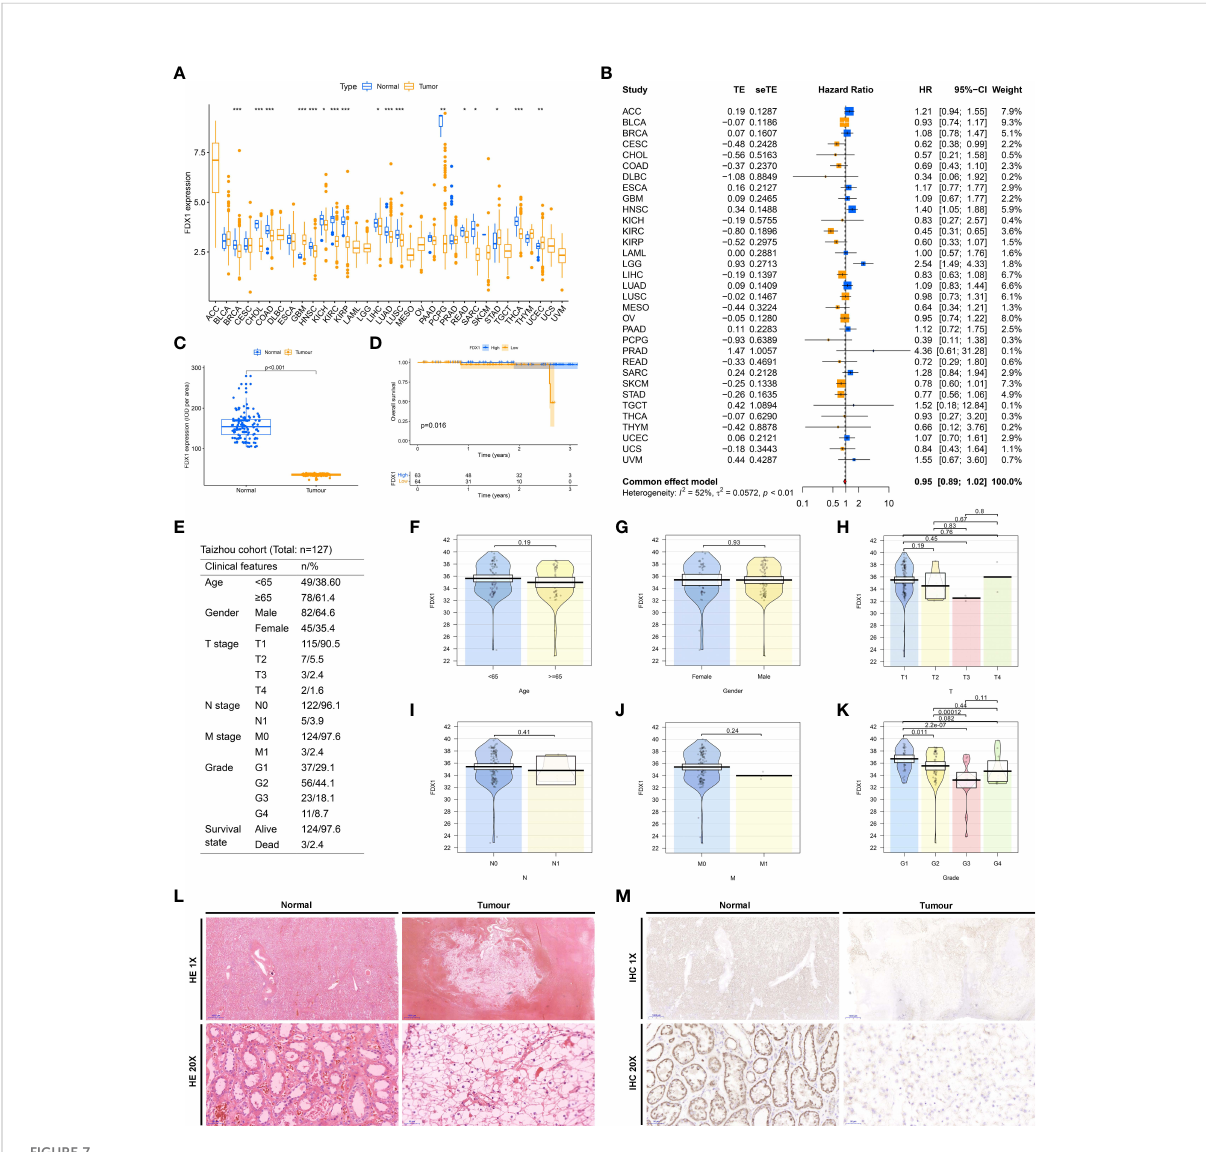
FIGURE 7 Clinical validation of FDX1. (A) Differential expression of FDX1 in TCGA pan-cancer. (B) A meta-analysis of the prognosis of pan-cancer with FDX1. (C) Differential expression of FDX1 in normal and tumor tissues in the Taizhou cohort. (D) Overall survival differences between high and low FDX1 expression groups in the Taizhou cohort. (E) Table of clinicopathological characteristics of the Taizhou cohort. Differences in clinicopathological characteristics, including Age (F) , and Gender (G) , T stage (H) , N stage (I) , and M stage (J) , Grade (K) , between high and low FDX1 expression groups in the Taizhou cohort. (L) HE staining of tumors and adjacent normal renal tissues in Taizhou cohort. (M) Immunohistochemical detection of FDX1 in tumors and adjacent normal renal tissues in Taizhou cohort. * P < 0.05, ** P < 0.01, *** P <